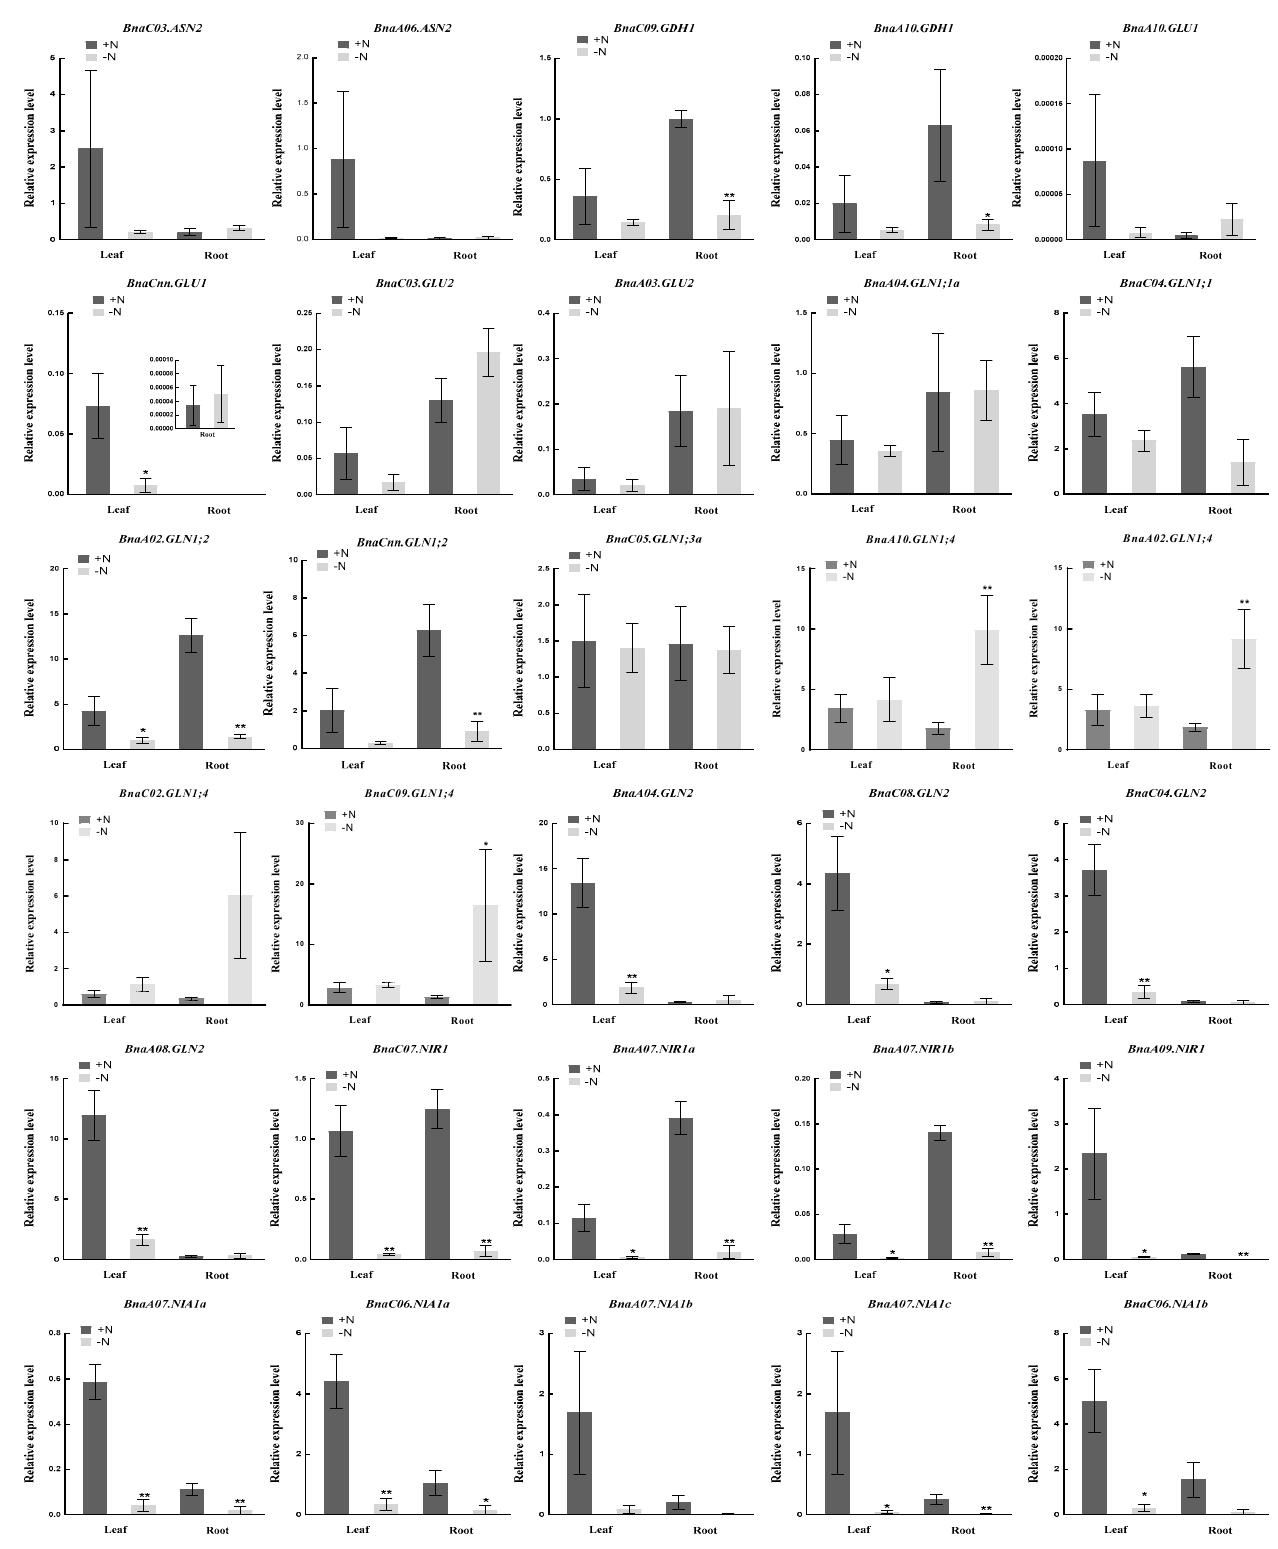
Figure 9. The expression profiles of 30 genes involved in nitrogen assimilation in the leaf and root of Brassica napus under nitrogen (N) stress by qRT-PCR. Seedlings of 14 days old were exposed to N-free nutrient solution for six days. The root and leaf were sampled separately for RNA extraction. +N, sufficient nutrient supply (6 mM N); -N, N stress (0 mM N) condition. * and ** indicate significant difference at p < 0.05 and p < 0.01 by Student’s t -test, respectively.